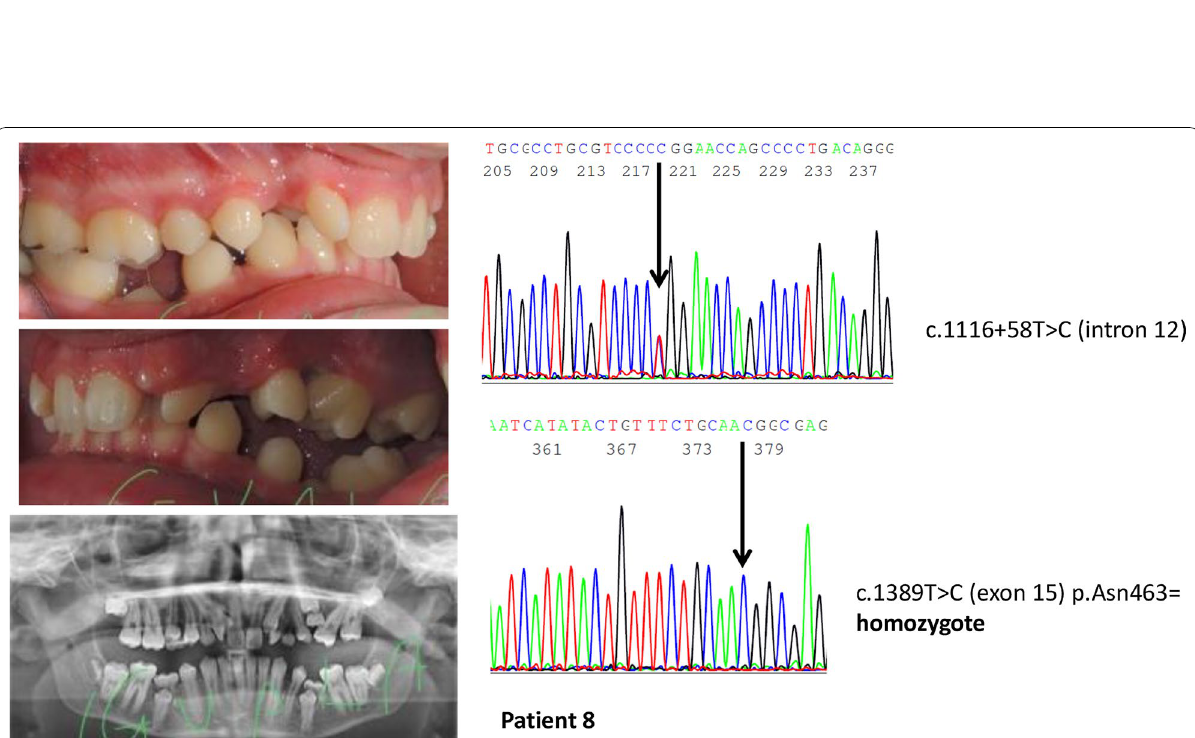
Fig. 2 Clinical features and genetic findings of patient 8 with PFE and both a synonymous and an intronic PTH1R